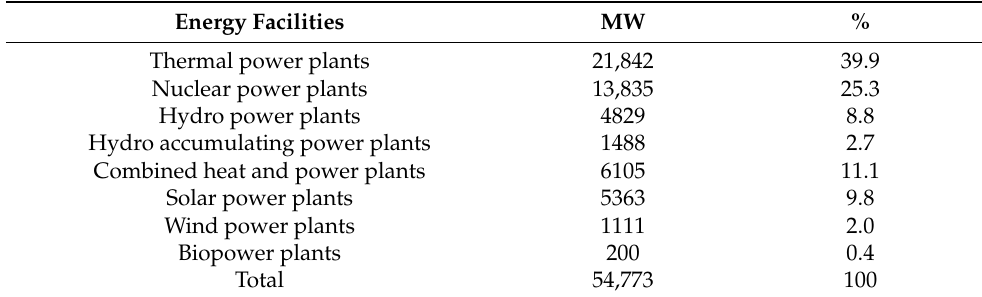
Table 6. Installed capacity of Ukraine’s power facilities in 2020, MW [74]. Energy Facilities